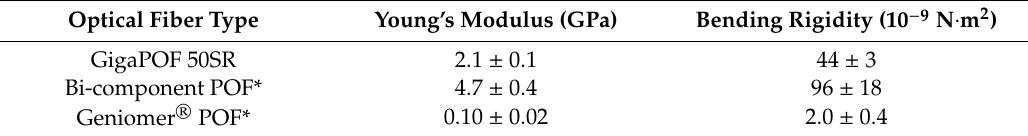
Table 1. Young’s moduli and bending rigidity of the POFs used. *POF provided by the Empa.